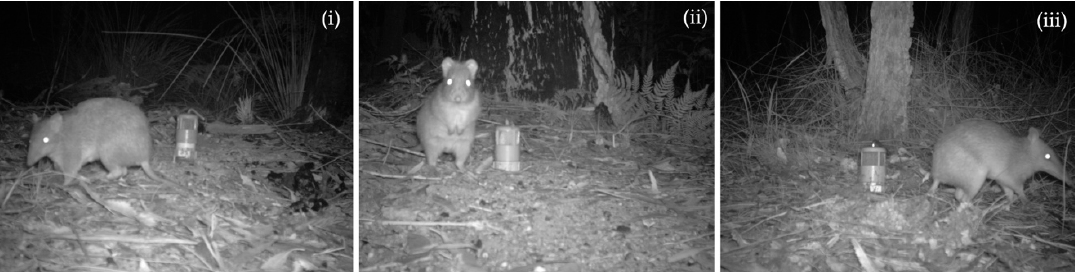
Figure 1. Night-time monochrome images captured by camera-traps of the three target species monitored in this study: (i) southern brown bandicoot Isoodon obesulus , (ii) long-nosed potoroo Potorous tridactylus , and (iii) long-nosed bandicoot Perameles nasuta . For scale, the containers used to hold bait also in the images are approximately 0.2 m high.